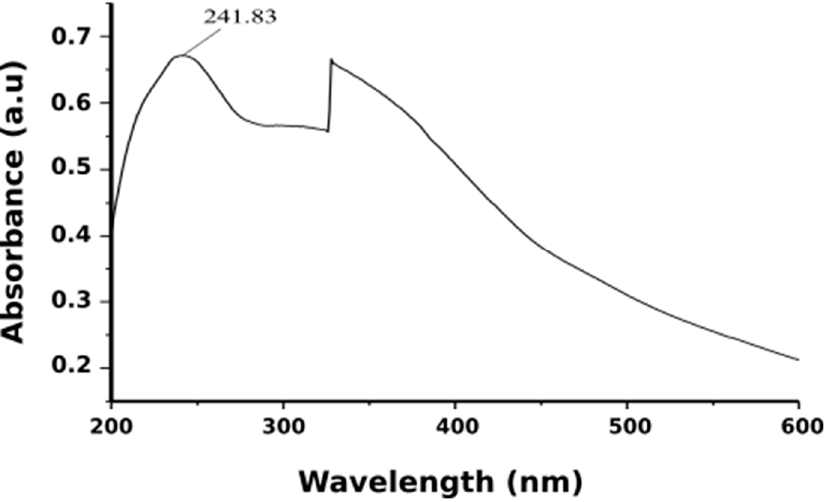
Figure 3. UV-visible absorption spectra of iron oxide nanoparticles.